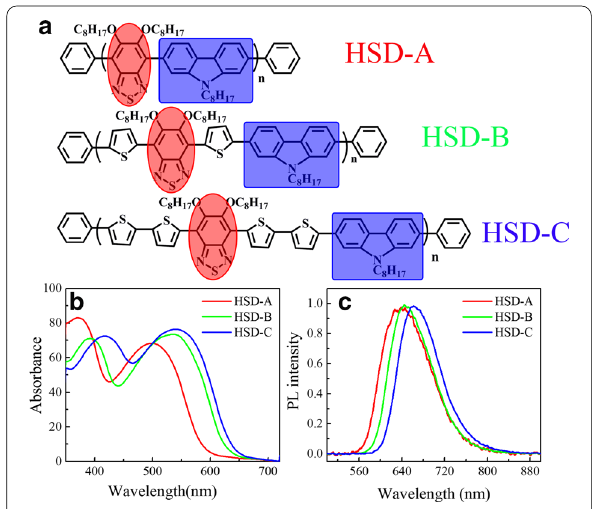
Fig. 1 Molecular structures of three polymers ( a ) in this work. Shaded blue and shaded red denote the donor and acceptor parts, respectively. Steady-state absorption spectra ( b ) and steady-state photoluminescence spectra ( c ) of three samples, HSD-A (red), HSD-B (green), HSD-C (blue), measured in